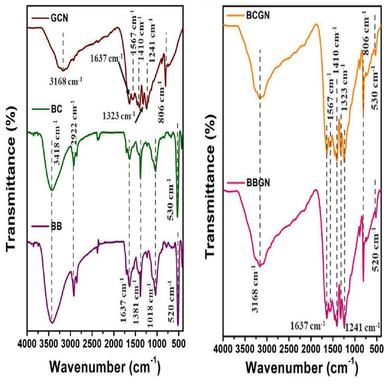
FTIR spectra of (a) BB, BC, GCN and (b) BBGN, BCGN nanomaterials.